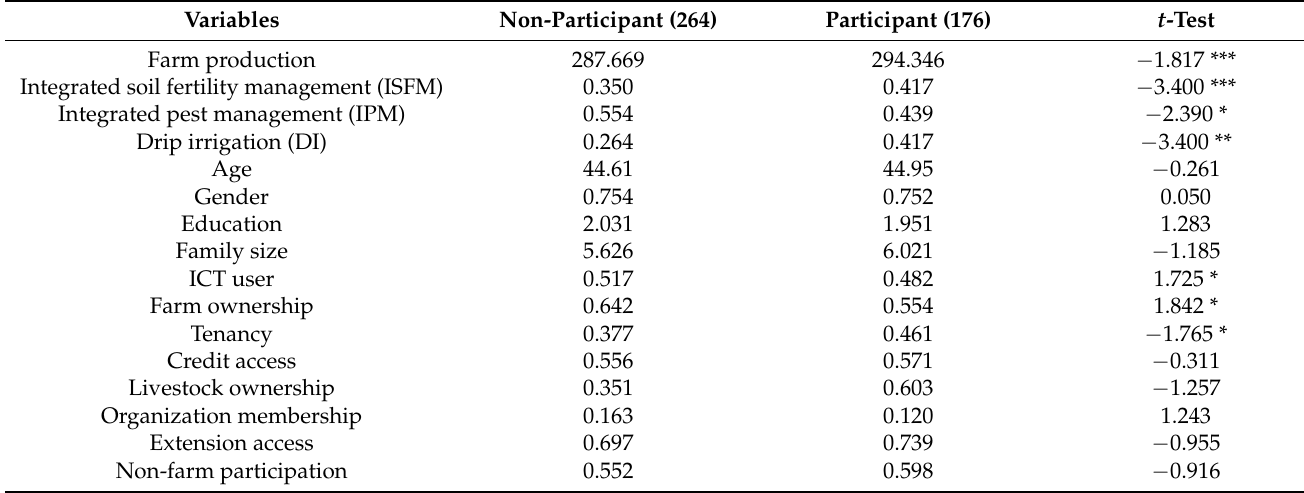
Table 2. Differences in characteristics between participants and non-participants of the farmers’